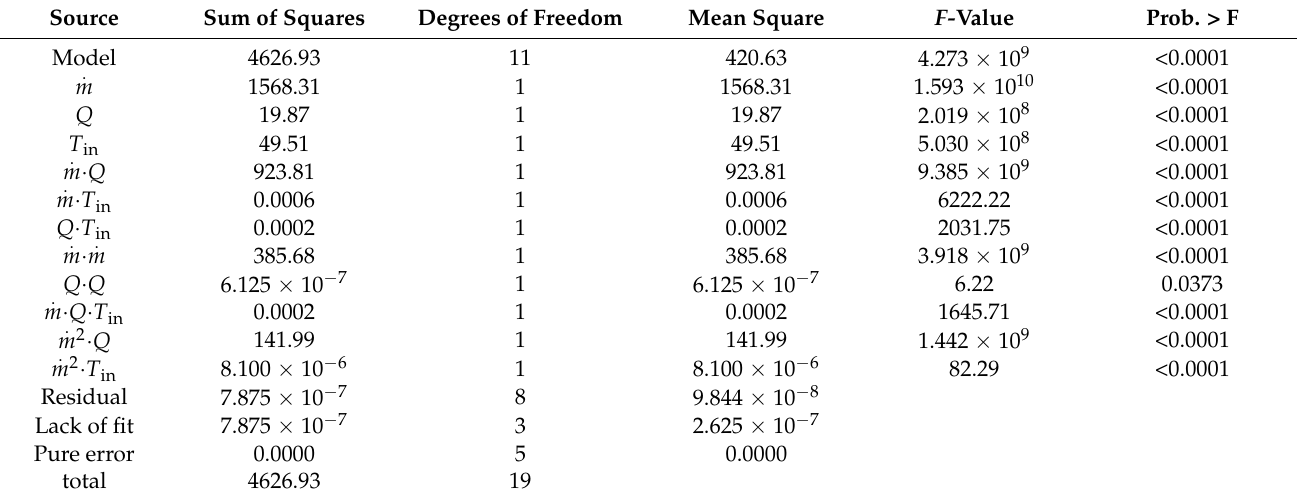
Table A1. The ANOVA for the average temperature (after backward